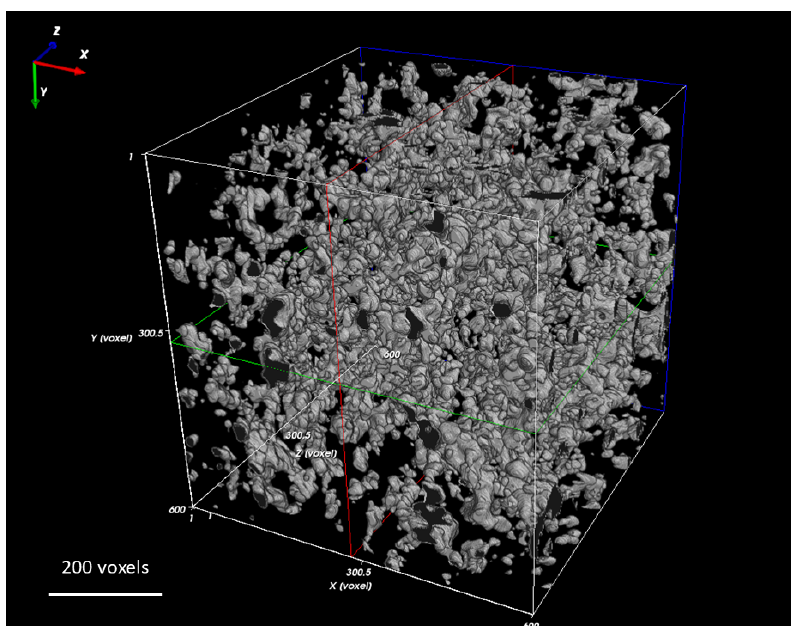
Figure 3. Pore space of mudstone (sample 27), poROSE software.